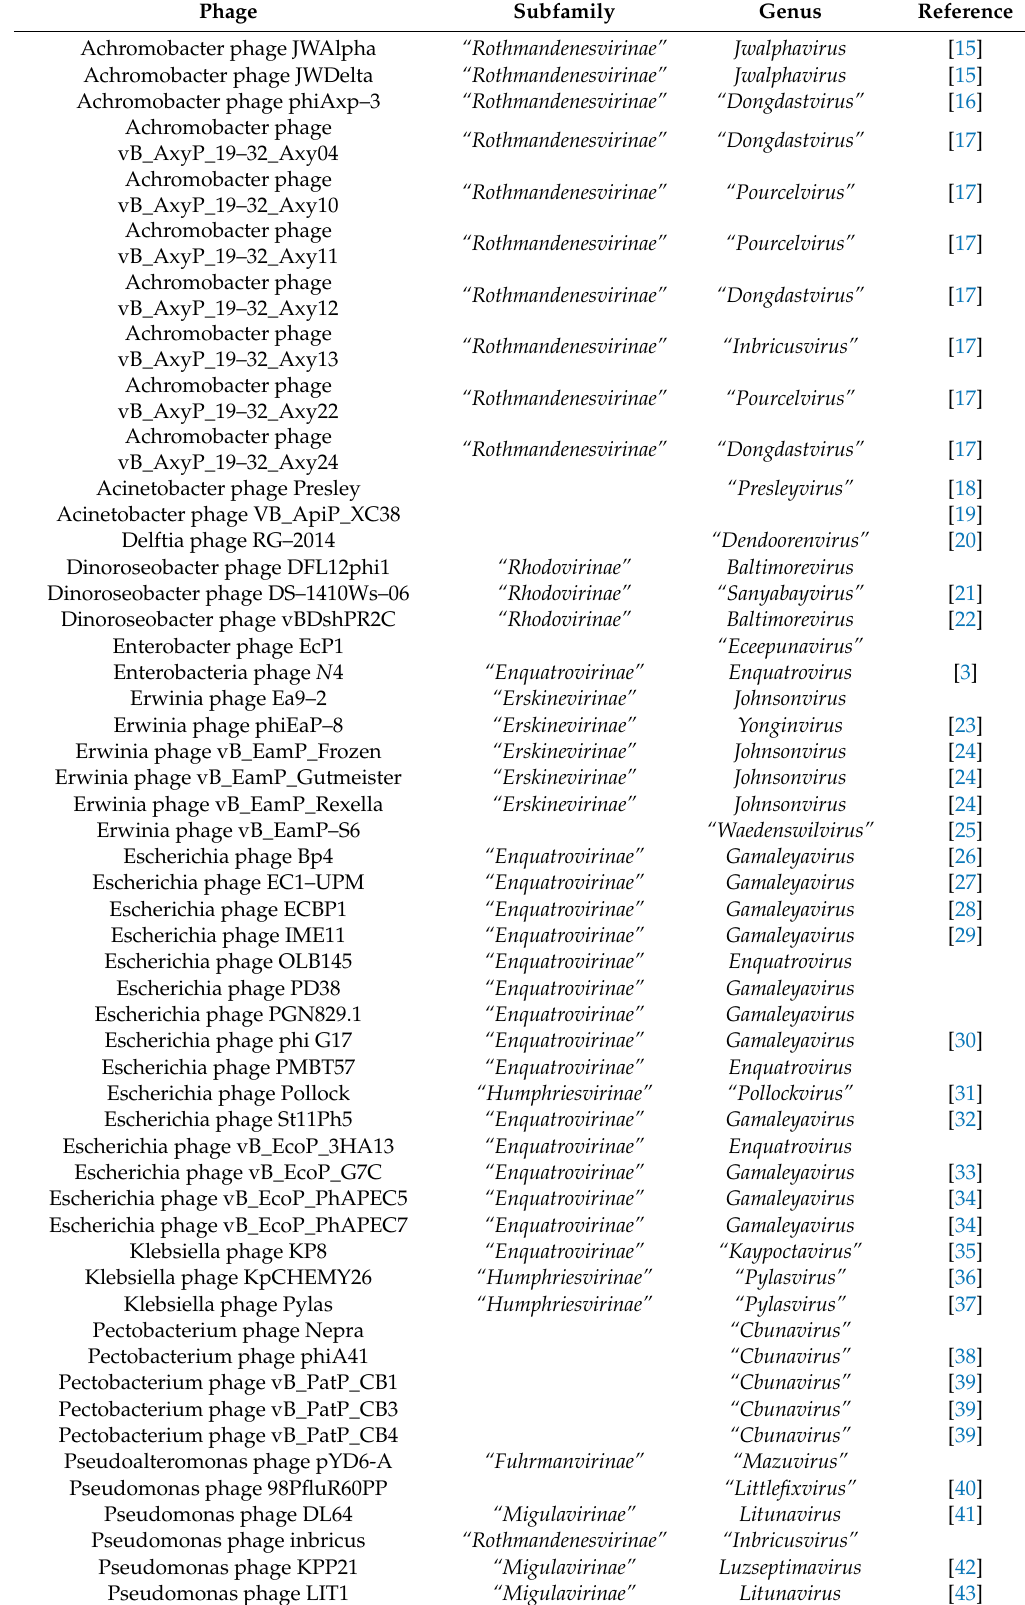
Table 1. List of N4-like genomes proposed to belong to the new family “ Schitoviridae ” available from INSDC